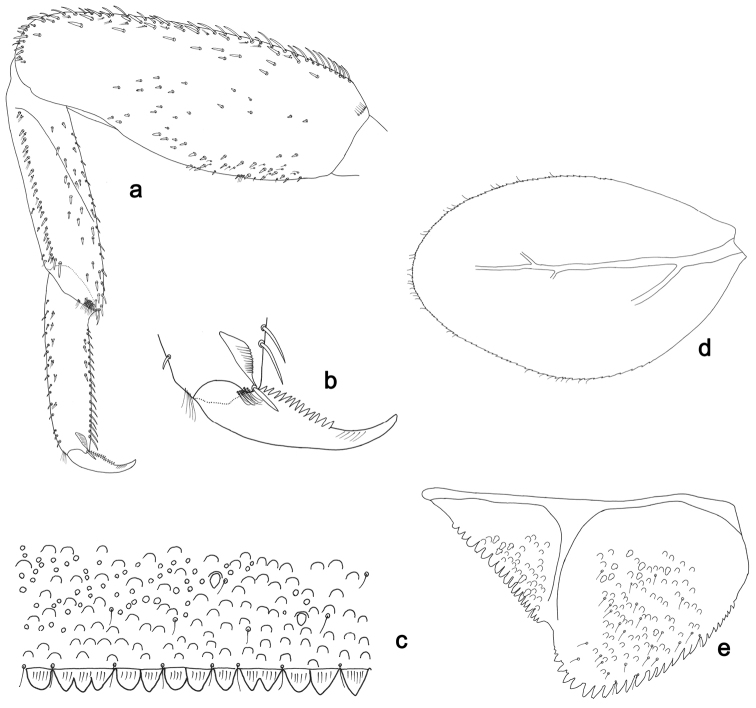
Labiobaetiswilhelmensis sp. n., larva morphology: aForelegb Fore claw cTergum IV d Gill IV eParaproct.